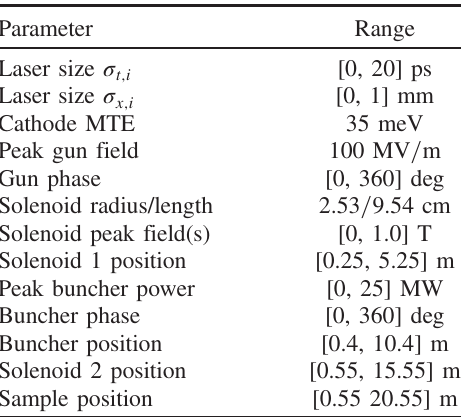
TABLE II. Beam line simulation parameters.